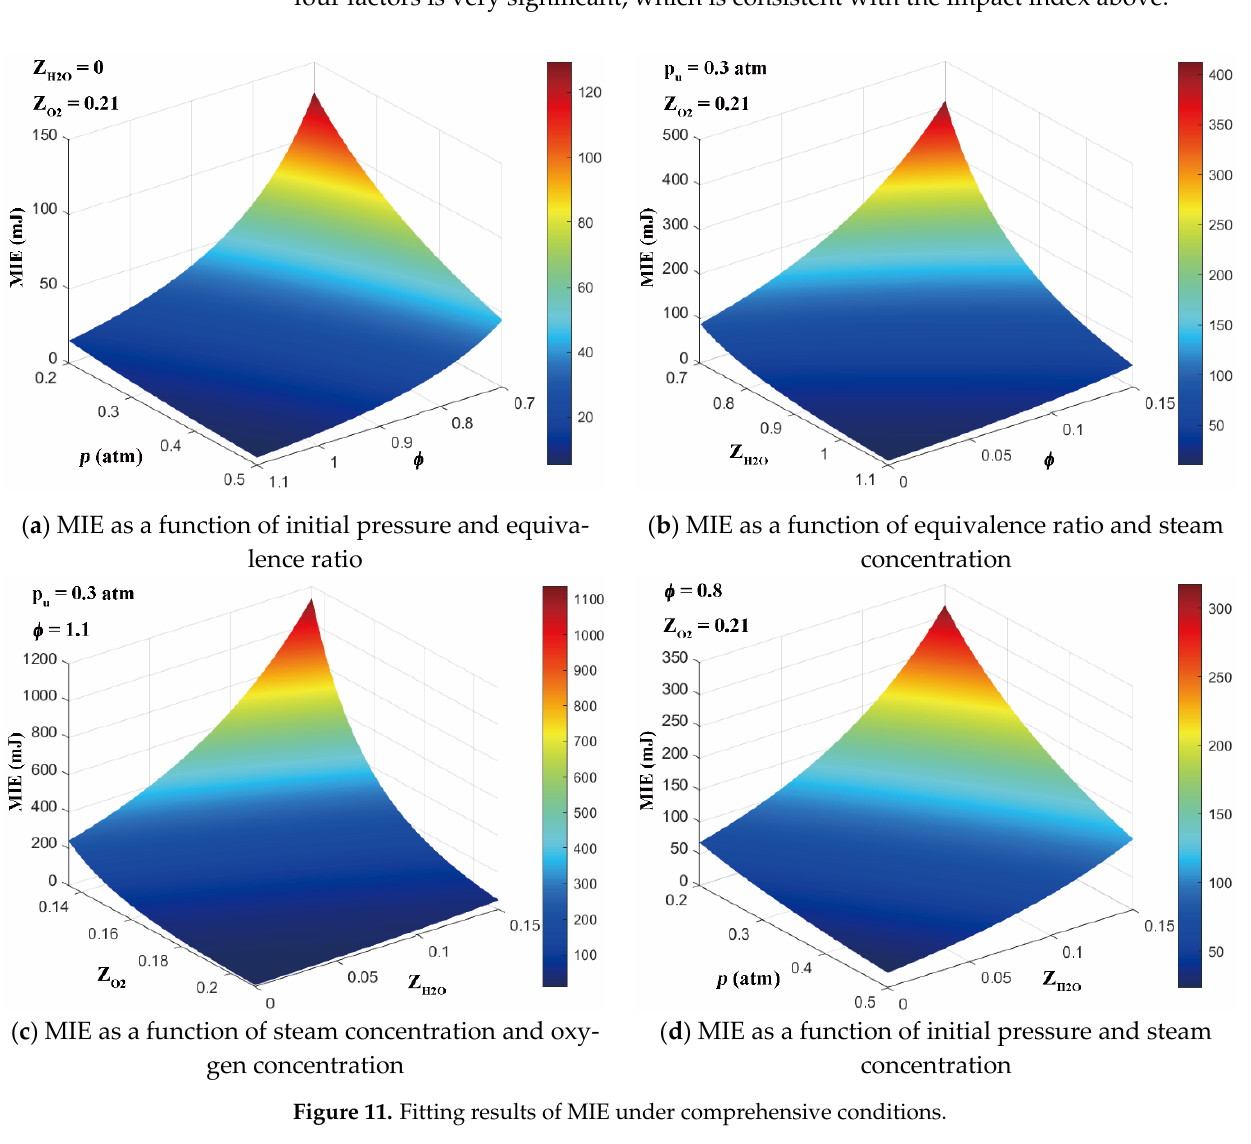
Figure 11. Fitting results of MIE under comprehensive conditions.